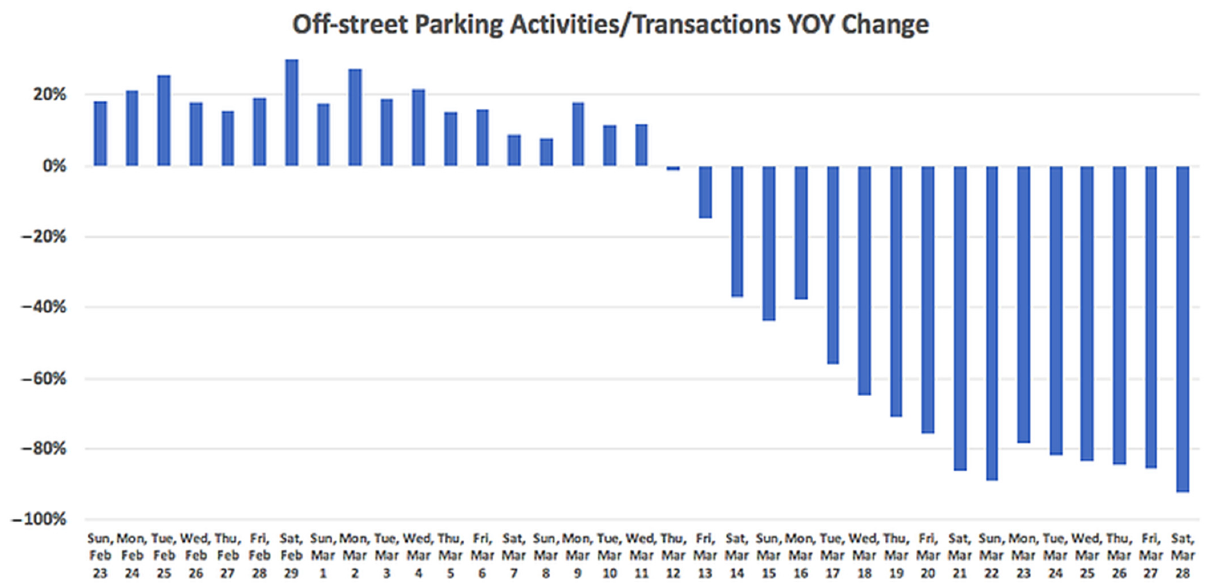
Figure 4. Off-street parking activities YOY change (from a random sample of 511 zones/blocks across the USA).